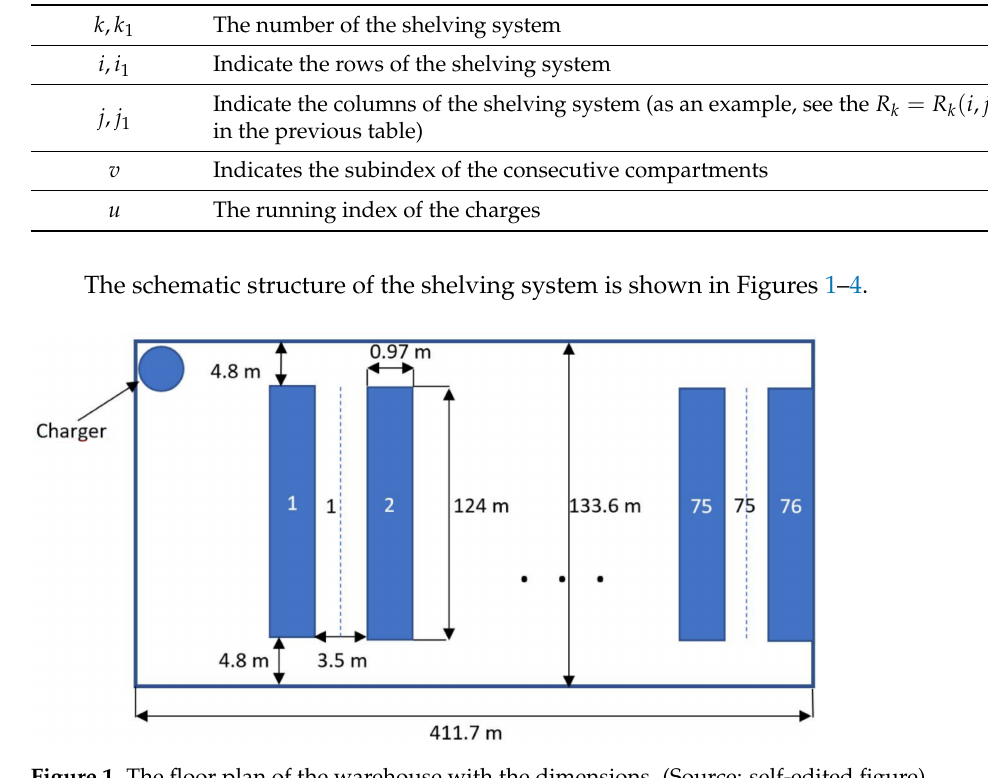
Figure 1. The floor plan of the warehouse with the dimensions. (Source: self-edited figure).